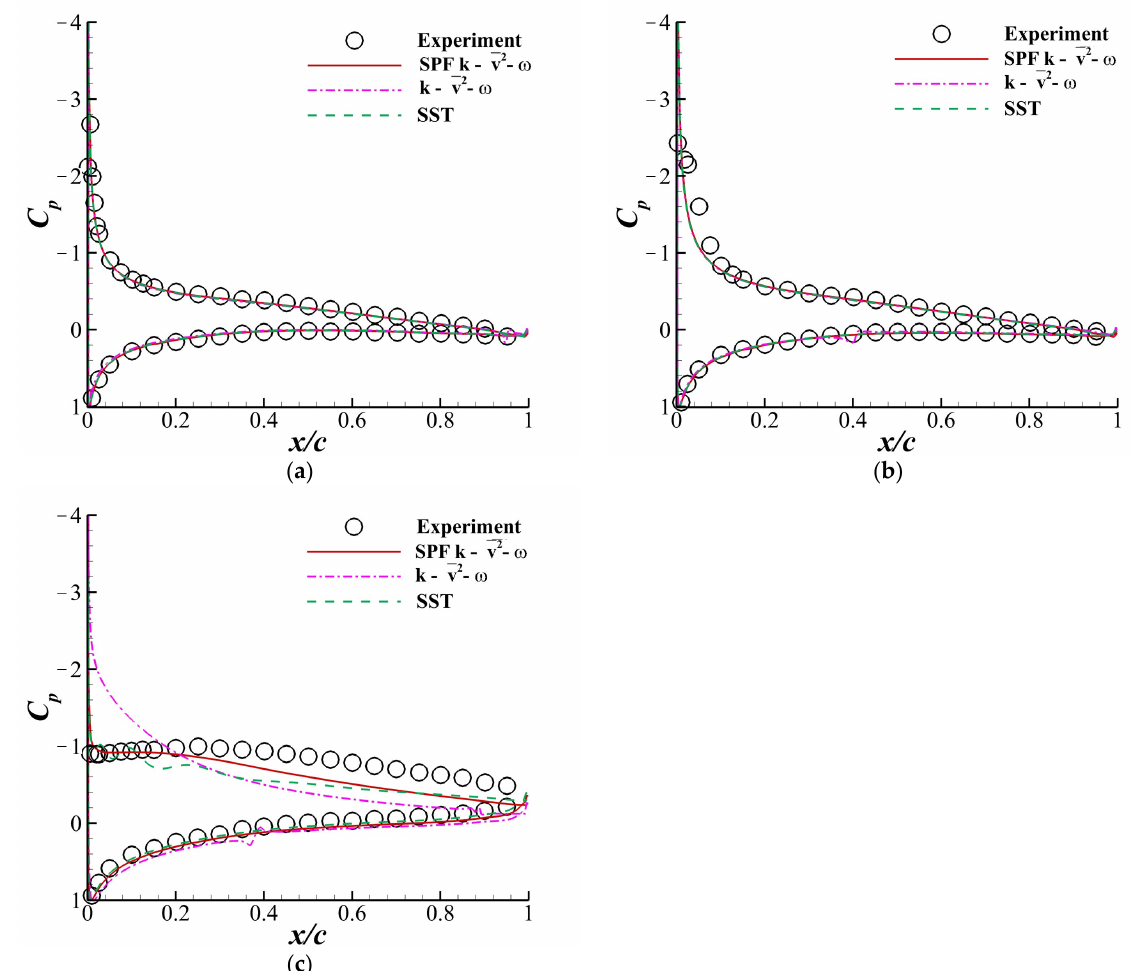
Figure 12. 𝐶 (cid:3013) − 𝐴𝑂𝐴 curve obtained by different turbulence models for the NACA64A006 airfoil Figure 12. C L − AOA curve obtained by different turbulence models for the NACA64A006 airfoil when 𝑅𝑒 = 5.8 × 10 (cid:2874) and 𝑀𝑎 = 0.167. The circles represent the experimental data obtained by when Re = 5.8 × 10 6 and Ma = 0.167. The circles represent the experimental data obtained by McCullough et al. [35]. McCullough et al. [35].